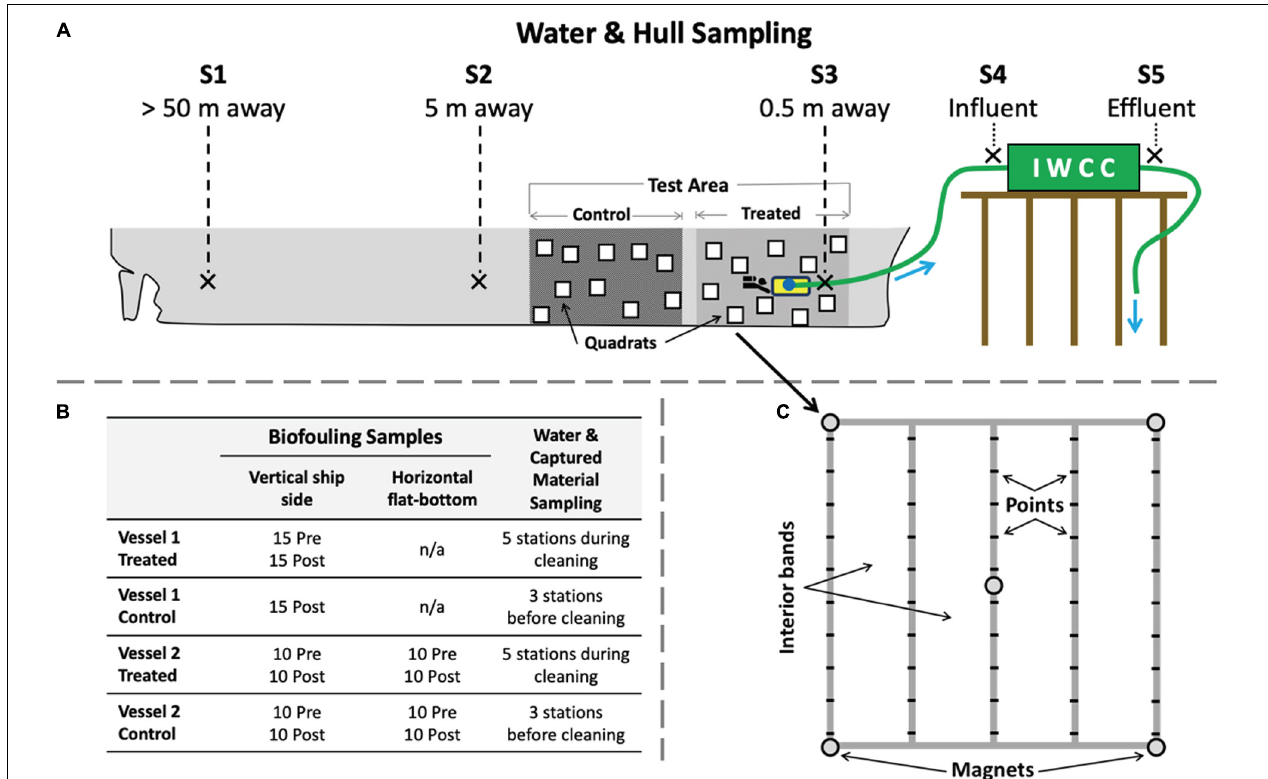
FIGURE 1 | Overview of sampling design for biofouling and water quality testing. (A) Diagram (not to scale) showing locations of large hull areas in which quadrat samples were taken to measure biofouling before and after the cleaning event for each designated control and treated (cleaned) areas. Flat-bottom test areas were also included for Vessel 2. Water quality sampling took place at shipside stations S1 to S5, at distances of 50 m (S1), 5 m (S2), and 0.5 m (S3, attached to the cleaning device) from the cleaning event. Station S4 sampled the captured influent that was pumped from the cleaning unit prior to its entry to the processing container on the dock. Station S5 sampled effluent discharged from the processing container. Water quality sampling occurred at three additional background stations (B1, B2, and B3, not shown) to measure ambient conditions away from the vessel before and during tests. (B) Number of replicate quadrat measures for vertical and horizontal (flat-bottom) test areas by vessel, time, and sampling area and for water quality measures. (C) The 1 m 2 quadrat used for measuring biofouling communities throughout testing, which included 50 points and four interior